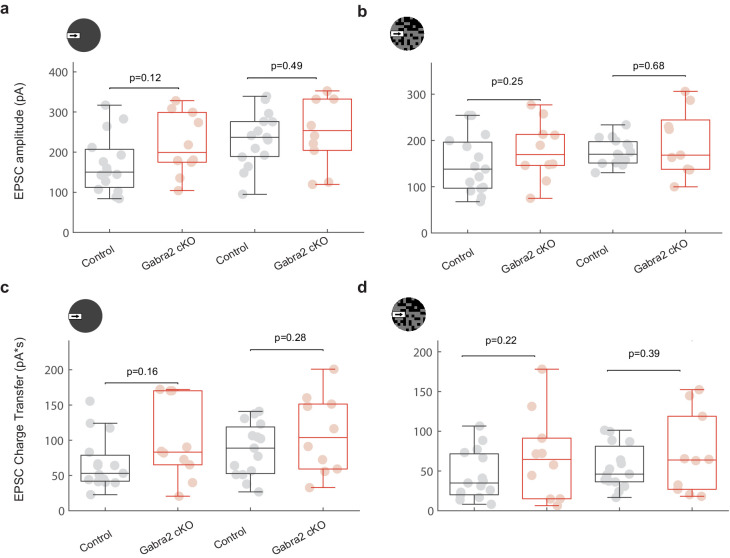
On-Off DSGC EPSCs are not affected in Gabra2 KO during the moving bar stimulus in the noisy background.(a) EPSC peak amplitudes in response to the moving bar in noise-free background in control (black) and Gabra2 cKO (red) mice. Left: null direction; Right: preferred direction. Control: 16 cells from six mice. Gabra2 cKO: 10 cells from eight mice. (b) Same as a, in the noisy background. (c) Same as a, for excitatory charge transfer (integral of EPSC over time). (d) Same as c, in the noisy background.Figure 1—figure supplement 3—source data 1.On-Off DSGC EPSCs are not affected inGabra2KO during the moving bar stimulus in the noisy background.